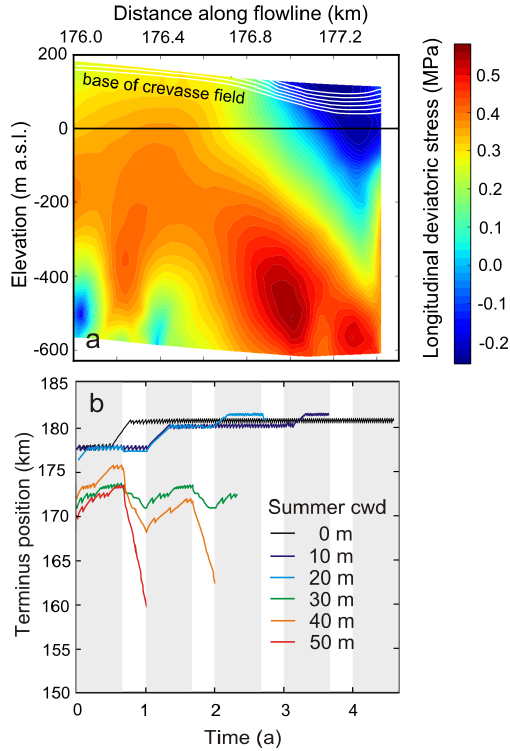
Fig. 3. Results of crevasse water depth (cwd) experiments. (a) Lon- gitudinal deviatoric stress near terminus (first timestep), showing the base of the crevasse field (white lines) with differing depths of water in crevasses from 0 to 50m. Lower profiles correspond to greater cwd. (b) Terminus position over the 5yr model run, grey shading indicates winter periods where there is no water in crevasses, white shading indicates summer where a range in cwd was applied. For clarity the terminus position shown is measured after each calving event. Experiments were terminated where the model reached the flotation